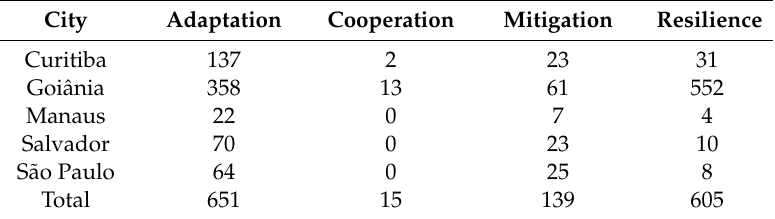
Table 8. Climate action references in city land use regulations.